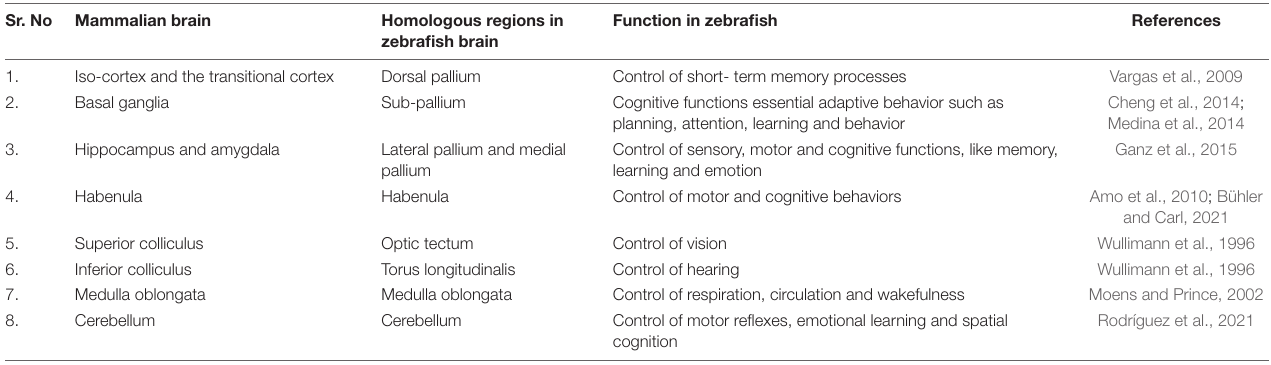
TABLE 1 | Comparison of regions of mammalian brains with their homologous counterpart in